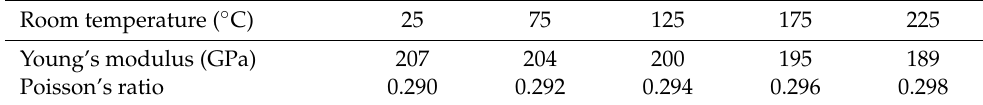
Table 1. Material properties of carbon steel at different temperatures